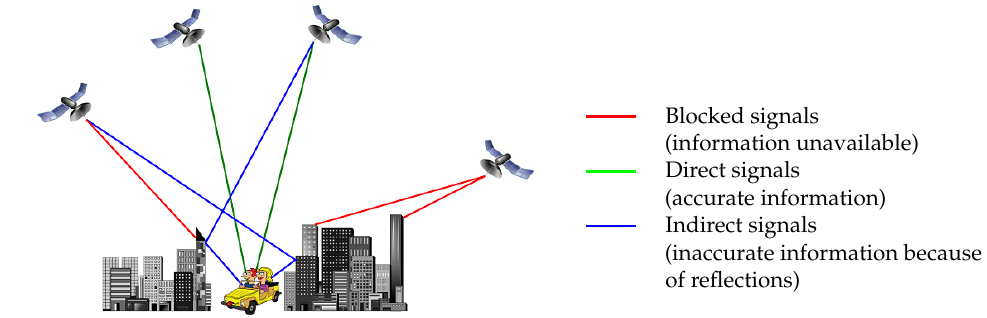
Figure 1. Multipath effect due to rays reflections.